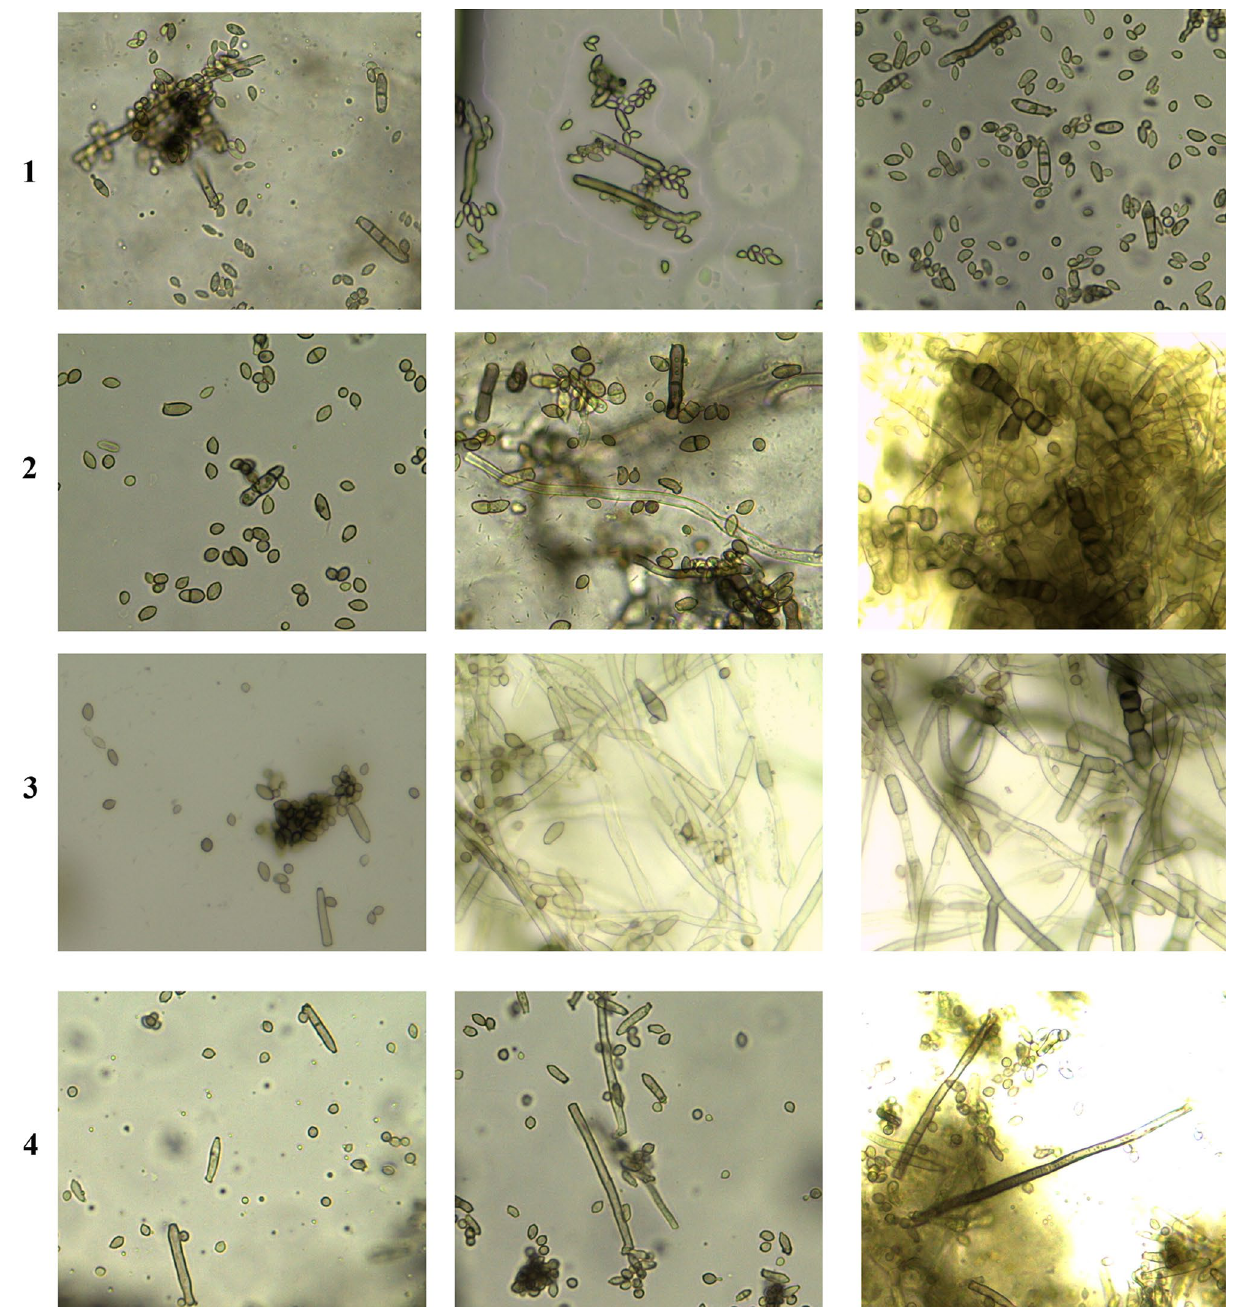
Figure 3. Ramoconidia, conidia, conidiophores and chlamydospores of (1): C. cladosporioides , (2): C. limoniforme , (3): C. ramotenellum and (4): C.